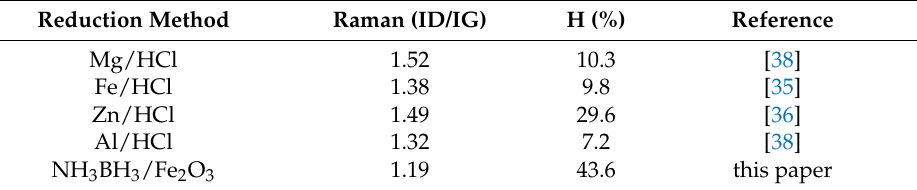
Table 1. Reduction efficiency of different metal/acid systems and our method.